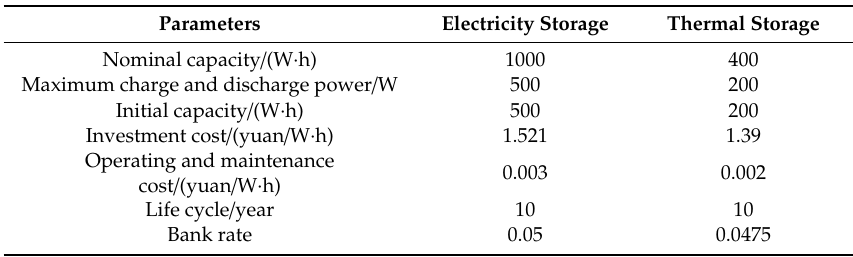
Table 1. Parameters of one storage unit.